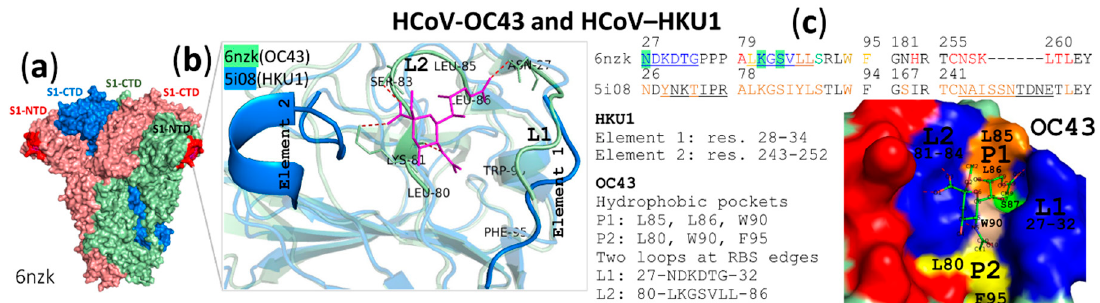
Figure 5. Comparison of Sia binding sites in S1-NTDs of HCoV-OC43 and HCoV-HKU1. ( a ) Side view of the position of RBSs (red) in S1-NTDs of the trimeric HCoV-OC43 spike bound with Neu5,9Ac 2 in magenta stick (pdb: 6nzk [193]). ( b ) Superimposition between the RBS of HCoV-OC43 pale green spike in complex with Neu5,9Ac 2 in magenta stick (pdb: 6nzk) and the RBS of HCoV-HKU1 marine spike (pdb: 5i08 [197]). Three aa residues (S83, N27 and K81) that directly interact with Neu5,9Ac 2 are shown in red sticks. ( c ) Alignment of aa sequences of HCoV-OC43 and HCoV-HKU1 S1-NTDs. Residues directly interacting with the receptor are highlighted green. Right: Residues covering the S1-NTD surface area facing the Neu5,9Ac 2 receptor, being the RBS, are at the canyon bottom with ridges of HKU1 elements 1 and 2 according to Hulswit et al. [92]. Two loops, L1 and L2, at RBS edges are shown in dark blue and two hydrophobic pockets are shown in orange (P1) and yellow (P2) separated by lightorange (W90) according to Tortorici et al. [193]. Red is the ridge in OC43 S1-NTD corresponding to HKU1 element 1.